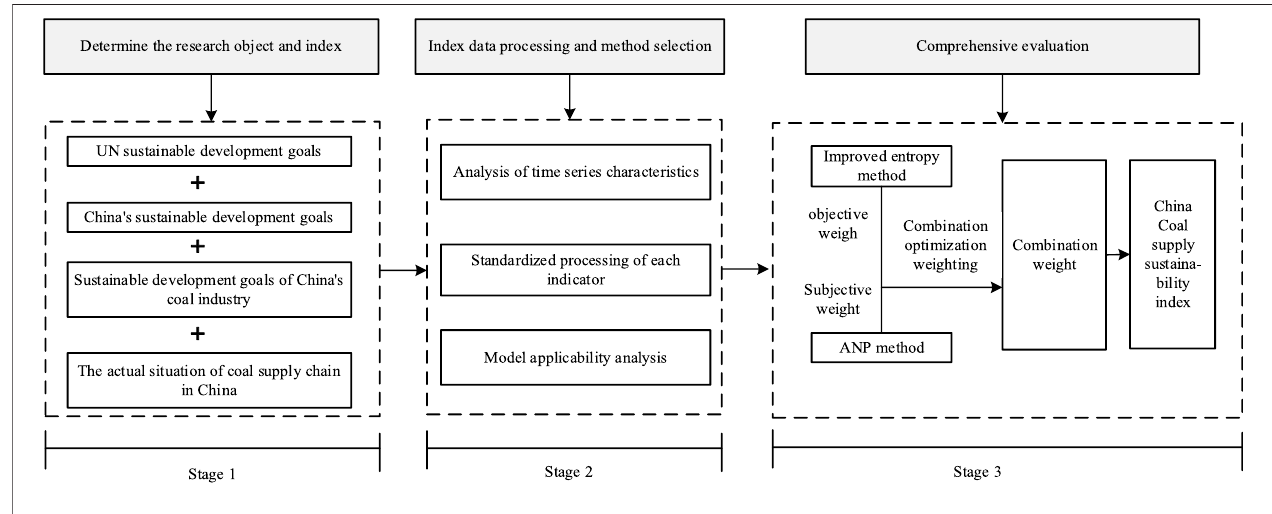
FIGURE 1 | The main research framework of this